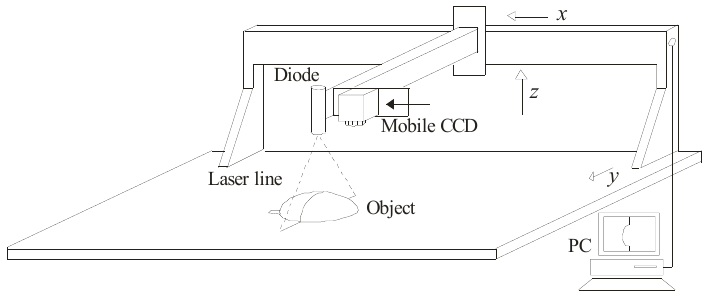
Figure 2. Mobile setup to perform the three-dimensional